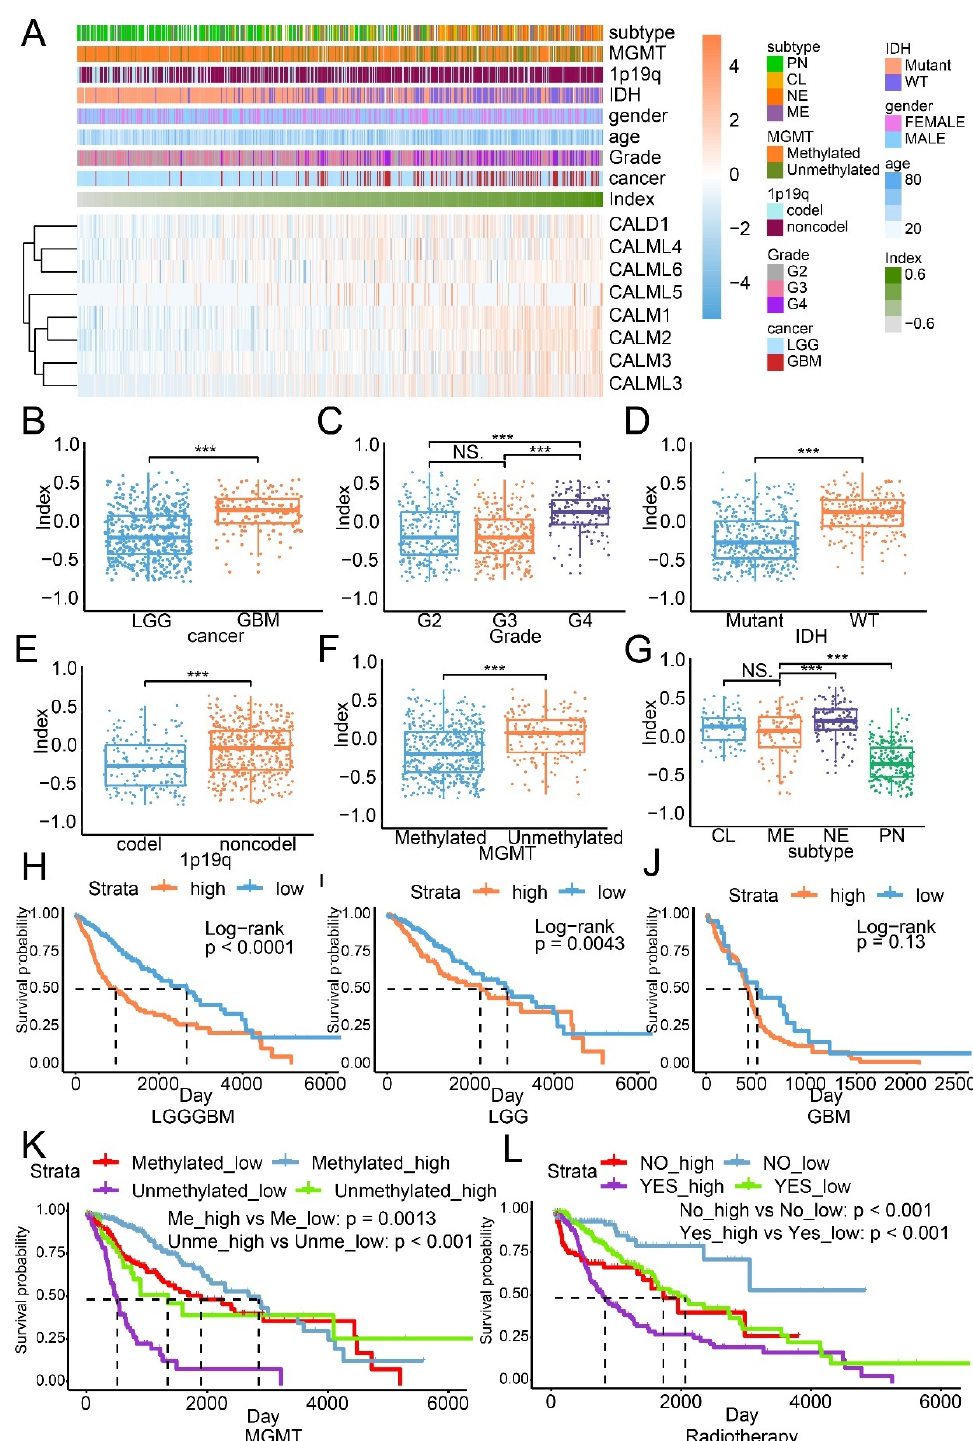
Figure 5. The CI model based on genes encoding calmodulin-dependent proteins in the TCGA dataset. ( A ) The distribution of CI was illustrated by a heatmap, along with clinical features and the expression of genes encoding calmodulin-dependent proteins. The association with cancer ( B ), WHO grade ( C ), IDH status ( D ), 1p19q status ( E ), MGMT status ( F ) and glioma subtype ( G ). The overall survival analysis based on the LGGGBM cohort ( H ), the LGG cohort ( I ) and the GBM cohort ( J ). The overall survival analysis based on the subgroup of MGMT status ( K ) and radiotherapy ( L ). NS: no statistical difference; ***: p value <